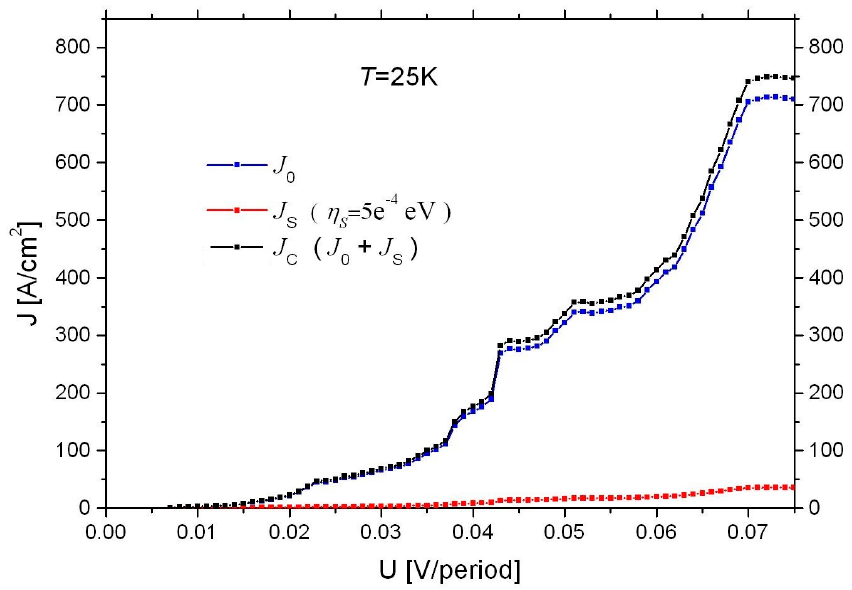
Figure 11. The current-voltage characteristics for the structure no. 2. described in []. The total current density J C (plotted in black) is the sum of ballistic current density J 0 (plotted in blue) and scattering current density J 0 (plotted in red). The simulations were performed with the WS base for T = 25 K.